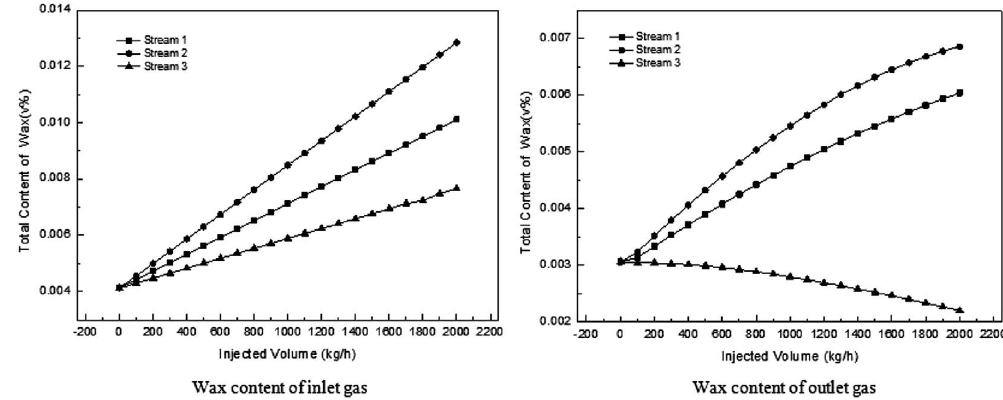
Fig. 9. The variation of wax content of inlet/outlet gas of high-pressure separator with the injected volume.